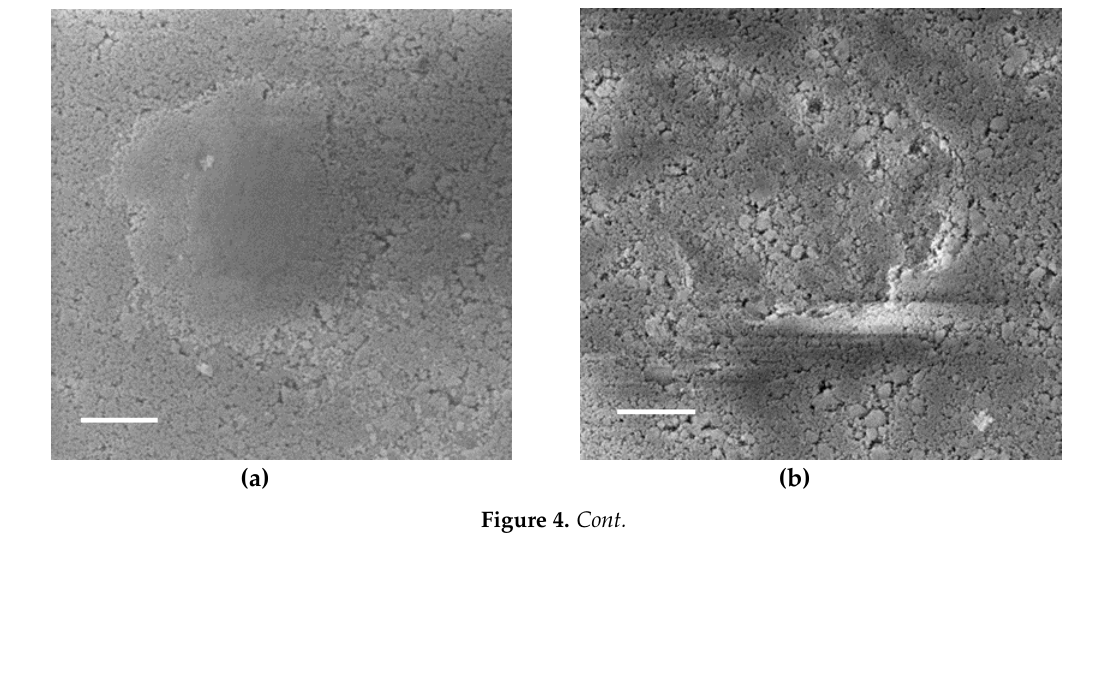
Figure 3. Contact stress – strain curves on FS (in green) and PS compacts (in blue) measured with a 2000-µm diameter sphere. Triangles illustrate the difference in slope between FS and PS